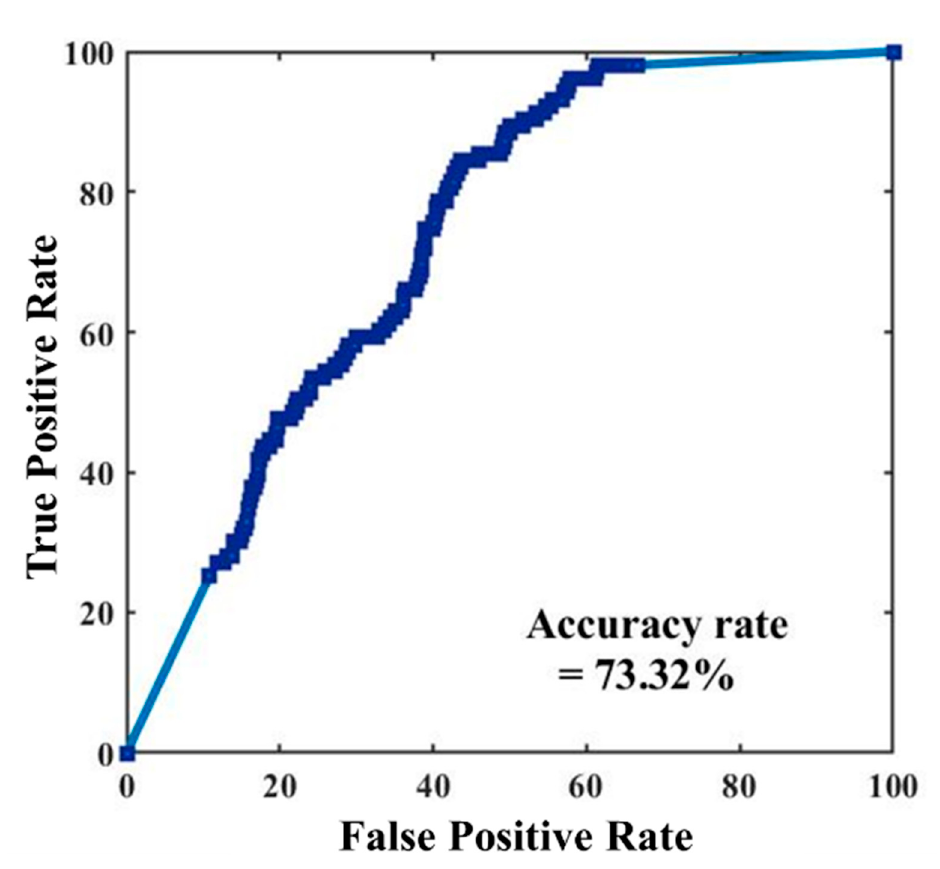
Figure 10. Receiver operating curve of the results from the Monte Carlo simulation. Table 4. Monte Carlo simulation results.